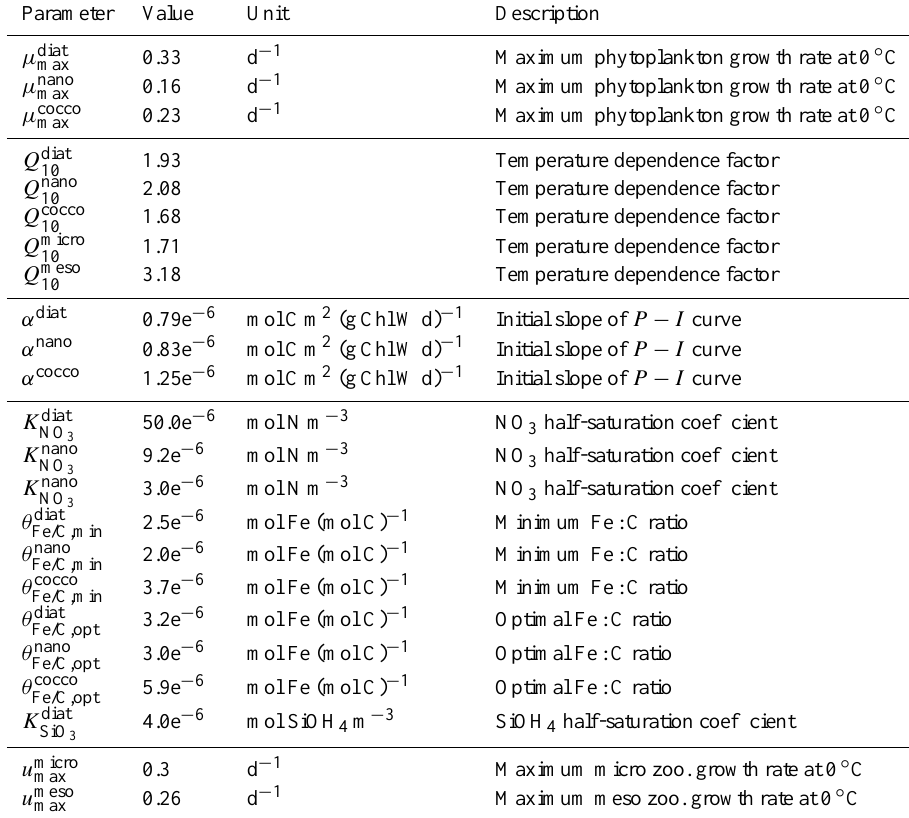
Table A7. PlankTOM5.3 parameters.